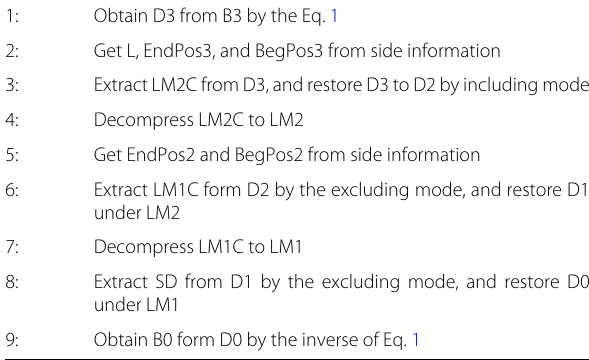
is colored with red in the figure, the PFR is replaced for